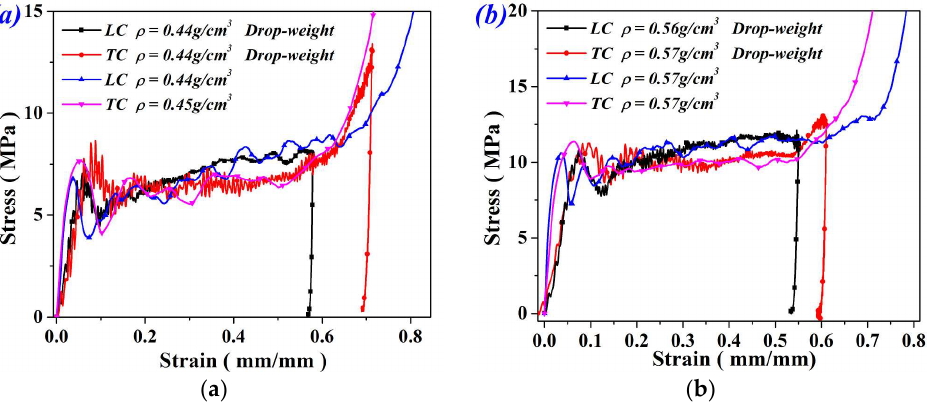
Figure 6. Mechanical response of ( a ) UFs and ( b ) FGs under impact compression.